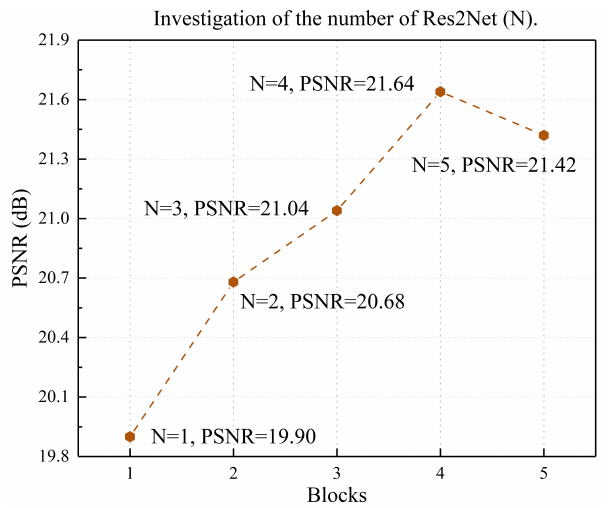
Figure 10. Investigate the effect of Res2Net block number for enhancement performance on the LOL dataset.